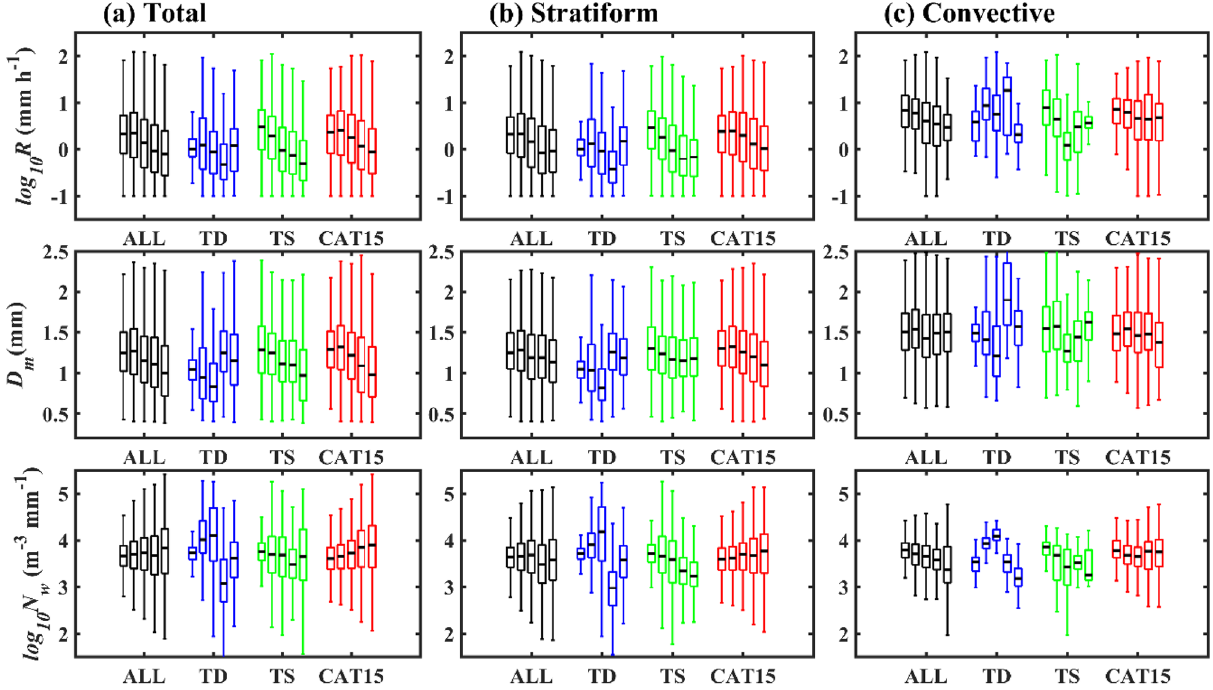
Figure 2. Variations in RSD parameters with radial distance for TCs of different category. Distribution of rainfall rate (log 10 R , R is in mm h –1 ) (first row), mass-weighted mean diameter ( D m , mm) (second row), and normalized intercept parameter (log 10 N w , N w is in m –3 mm –1 ) (third row) for ( a ) total, ( b ) stratiform, and ( c ) convective precipitations of all and different category (TD, TS, and CAT15) TCs at different radial distances [radial distance 1 (RD1: 0–100 km), radial distance 2 (RD2: 100–200 km), radial distance 3 (RD3: 200–300 km), radial distance 4 (RD4: 300–400 km), radial distance 5 (RD5: 400–500 km)]. Five box plots in each TCs category (All, TDs, TSs, and CAT15) denote RD1 to RD5, respectively, from left to (Fig. 2a), a slight increase (from RD1 to RD2) and a further decrease (from RD2 to RD5) in median values of D m and log 10 R with radial distance is apparent, which can be attributed to the relatively more significant number of small drops in outer regions (RD3–RD5) than inner regions (RD1 and RD2) (Supplementary Fig. 4). For TCs of all categories, the median values of log 10 N w increase with the increase in radial distance. A further clas- sification of all TCs into three categories (TDs, TSs, and CAT15) depicts that the RSD parameters ( D m , log 10 N w , and log 10 R ) of TDs have an inhomogeneous distribution with radial distance. However, for TSs, median values of D m and log 10 R decrease and log10 N w increase, except at RD4. In the case of TCs of CAT15, D m and log 10 R median values increase (RD1–RD2) and then decrease, and log 10 N w values increase. Segregation of TCs of dif- ferent categories into two precipitation (stratiform and convective) types shows that the RSD parameters (log 10 R , D m , and log 10 N w ) in stratiform precipitation (Fig. 2b) follow the similar tendency to that of the total precipita- tion (Fig. 2a). In convective precipitation, TSs’ RSD parameters (log 10 R and D m ) decrease (RD1–RD3) and then increase (RD3–RD5). Whereas, for TCs of CAT15, the median values of the three RSD parameters decrease from the TC center. Despite that, for the first two radial distances (RD1–RD2), TCs of CAT15 show higher (lower) median values of D m (log 10 N w ) than TDs and TSs, and an opposite feature appears for the last two radial distances (RD4 and RD5) (Supplementary Fig. 5). Nevertheless, in most of the radial distances, rainfall rates are higher in TCs of CAT15 than TSs (except at RG1) (Supplementary Fig. 5), which can be attributed to a relatively more number of small size drops (smaller D m and larger log 10 N w values) in TSs than CAT15. Figure 3 demonstrates the contour frequency by altitude diagrams (CFADs) of radar reflectivity for different radial distances (RD1–RD5) of TCs. For all TCs, the occurrence of 30 dBZ reflectivity is extended up to 7 km in RD1 and RD2, and its extent is limited up to around 6 km for the rest of the radial distances (RD3, RD4, and RD5). Below the melting layer (< 5 km), the reflectivity occurrence frequency of 2–4% is spread between 10–36 and 10–38 dBZ, respectively, for RD1 and RD2; nonetheless, RD2 exhibit relatively higher percentage (> 3.5%) than RD1. On the other hand, in the warm rain region (< 5 km), the reflectivity occurrence frequency of 2–4% shifts towards lower reflectivity values from RD3 to RD5 (~ 2 to 35 dBZ, 2–32 dBZ, and 2–30 dBZ for RD3, RD4, and RD5, respectively). The radar reflectivity higher percentage occurrence (> 4%) ranges between 15–35 dBZ, 25–35 dBZ, 18–28 dBZ, 2–18 dBZ, and 2–15 dBZ, respectively, for RD1, RD2, RD3, RD4, and RD5. The radar reflectivity CFADs of TDs exhibit an irregular distribution among five radial distances (RD1–RD5) with no consistent behavior from RD1 to RD5. Whereas, in the warm rain region (< 5 km) of TSs and CAT15, radar reflectivity occurrence frequency exhibit nearly vertical structure in the first two radial distances (RD1 & RD2) with a greater percentage occurrence in RD2 (RD1) for CAT15 (TSs). The reflectivity occurrence frequency